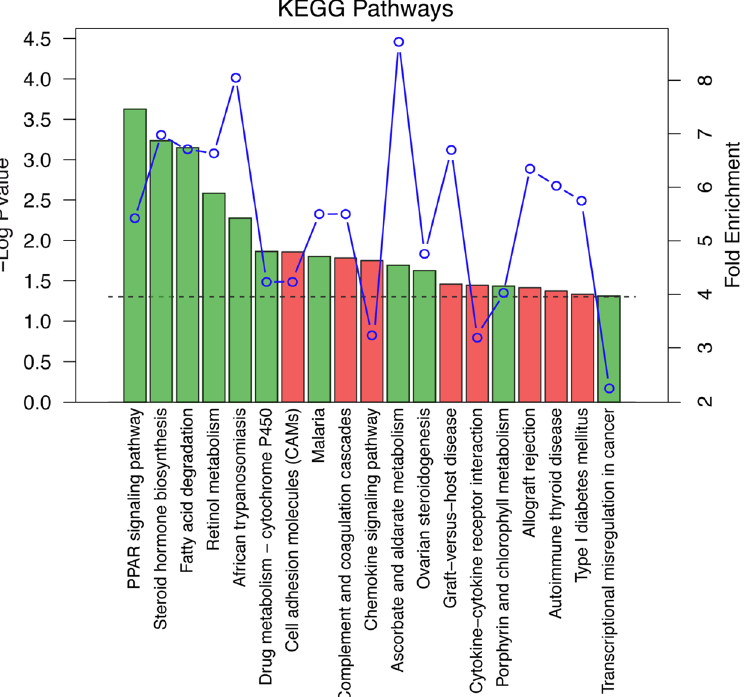
Figure 5. KEGG pathways enriched during the progression of renal disease in Tg Umod C147W identified by clusterProfiler Bioconductor package. The analysed list is composed of genes that are significantly up- or down-regulated in Tg Umod C147W female mice at 2 months of age, regardless of their fold change, and that are not differentially expressed at 1 month of age in sex-matched mice. Pathways up-regulated are represented by red bars while the down-regulated are green. The height of bars is proportional to the statistical significance of the term (dotted line corresponds to enrichment P value = 0.05). Fold enrichment of the significant terms is represented as a blue line. Fold enrichment is defined as the ratio gene frequency/background frequency (see Methods for